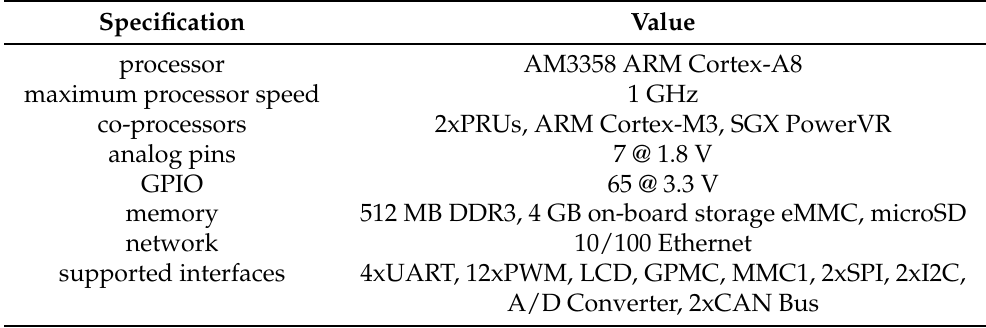
Table A2. Specifications of the ECU development